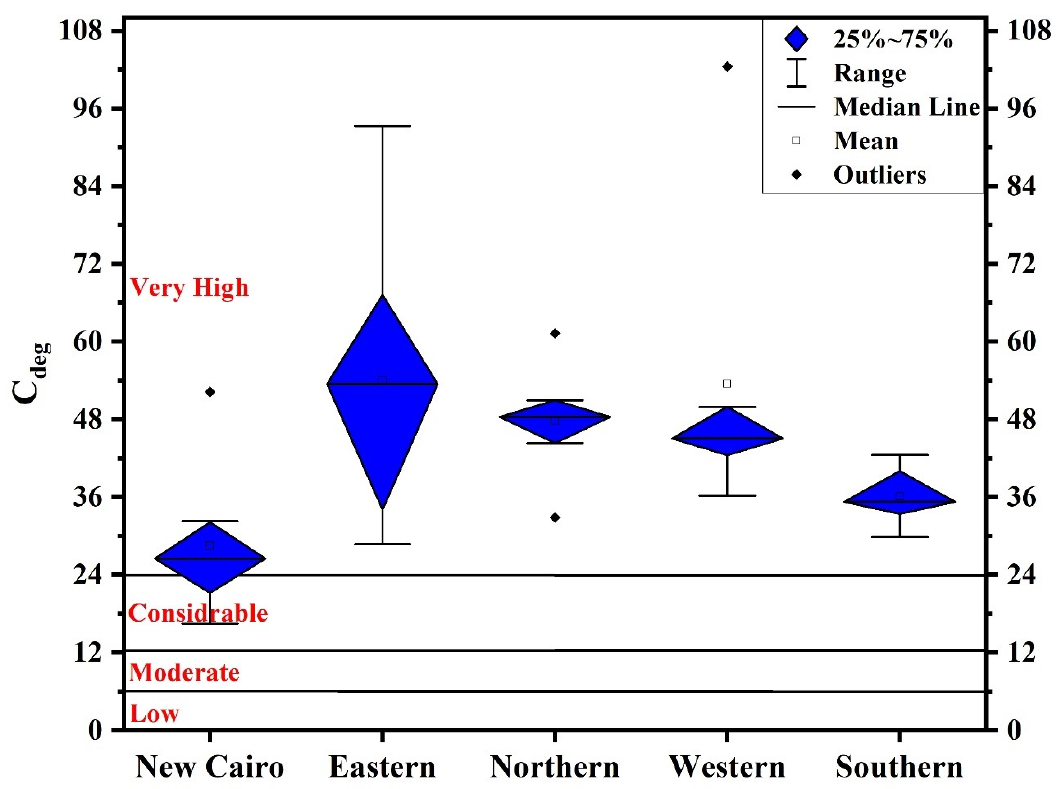
Figure 4. Boxplots of C deg values.